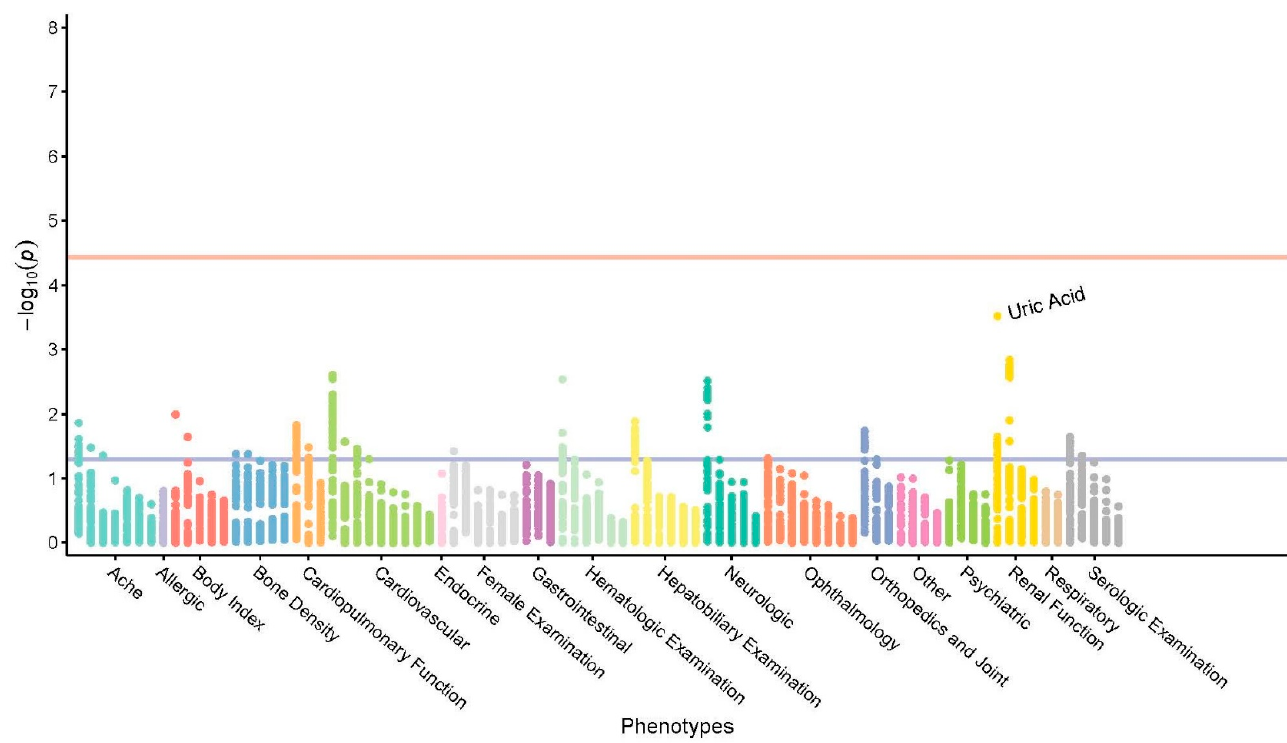
Figure 2. Phenome-wide scan for associations with WDR4 variants. The blue line represents p = 0.05, and the red line represents the significance level for phenome-wide associations after multiple testing corrections ( p = 3.65 × 10 − 5 ).